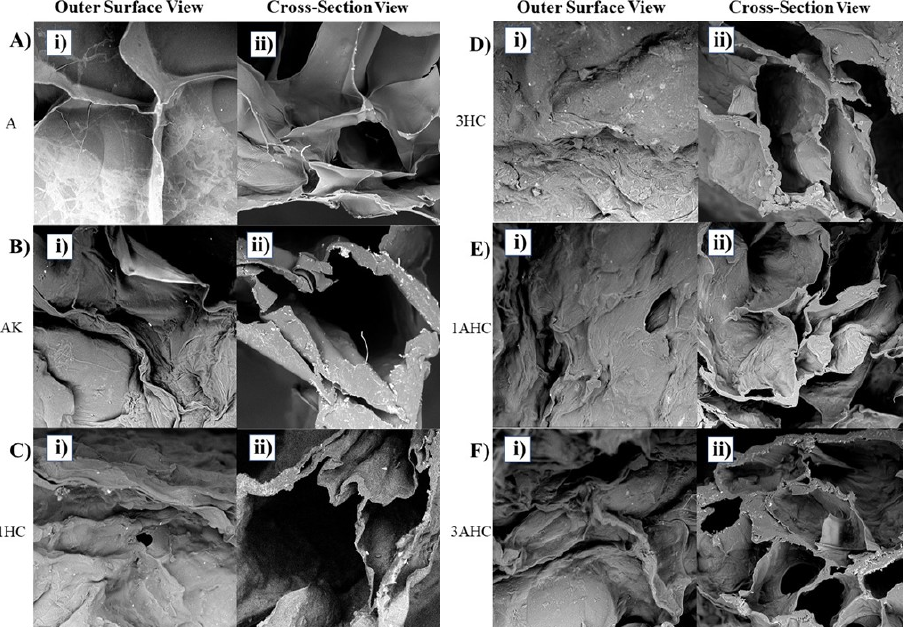
Figure 4. SEM micrographs of the fabricated bioscaffold. Each bioscaffold displayed ( i ) similar outer surface and ( ii ) cross-section features. ( A ): agar; ( B ): agar/KGM; ( C ): agar/KGM/0.01 g HC, ( D ): agar/KGM/0.03 g HC, ( E ): agar/KGM/0.01 g AHC; and ( F ): agar/KGM/0.03 g AHC.